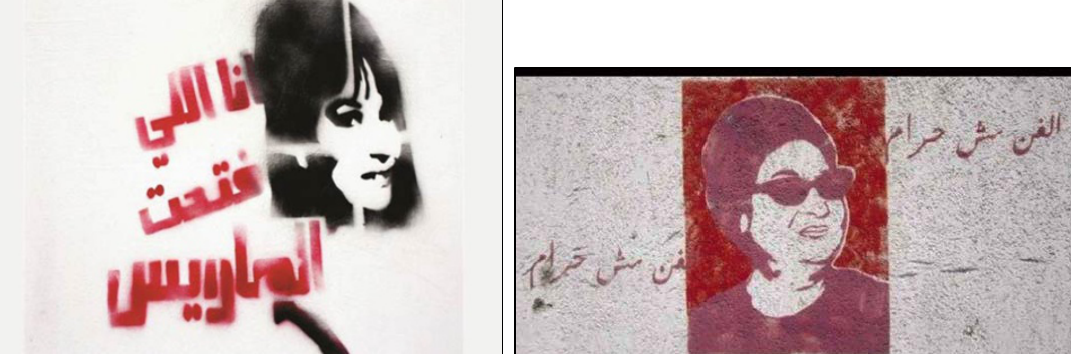
Figure8. I am the one who opened the sluice Figure9 . Art is not